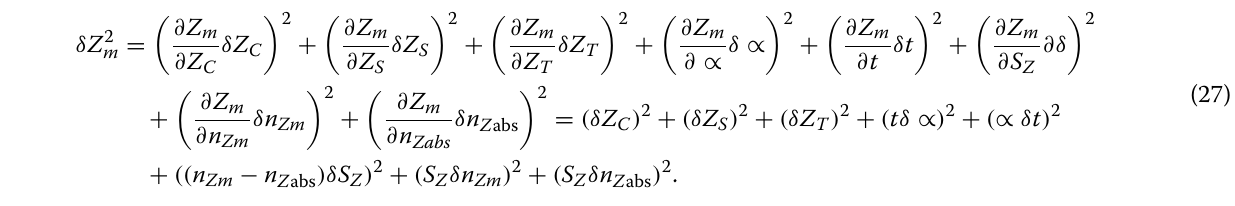
Table 4 Uncertainties for Z component Variable Value of the variable Uncertainty (δ)